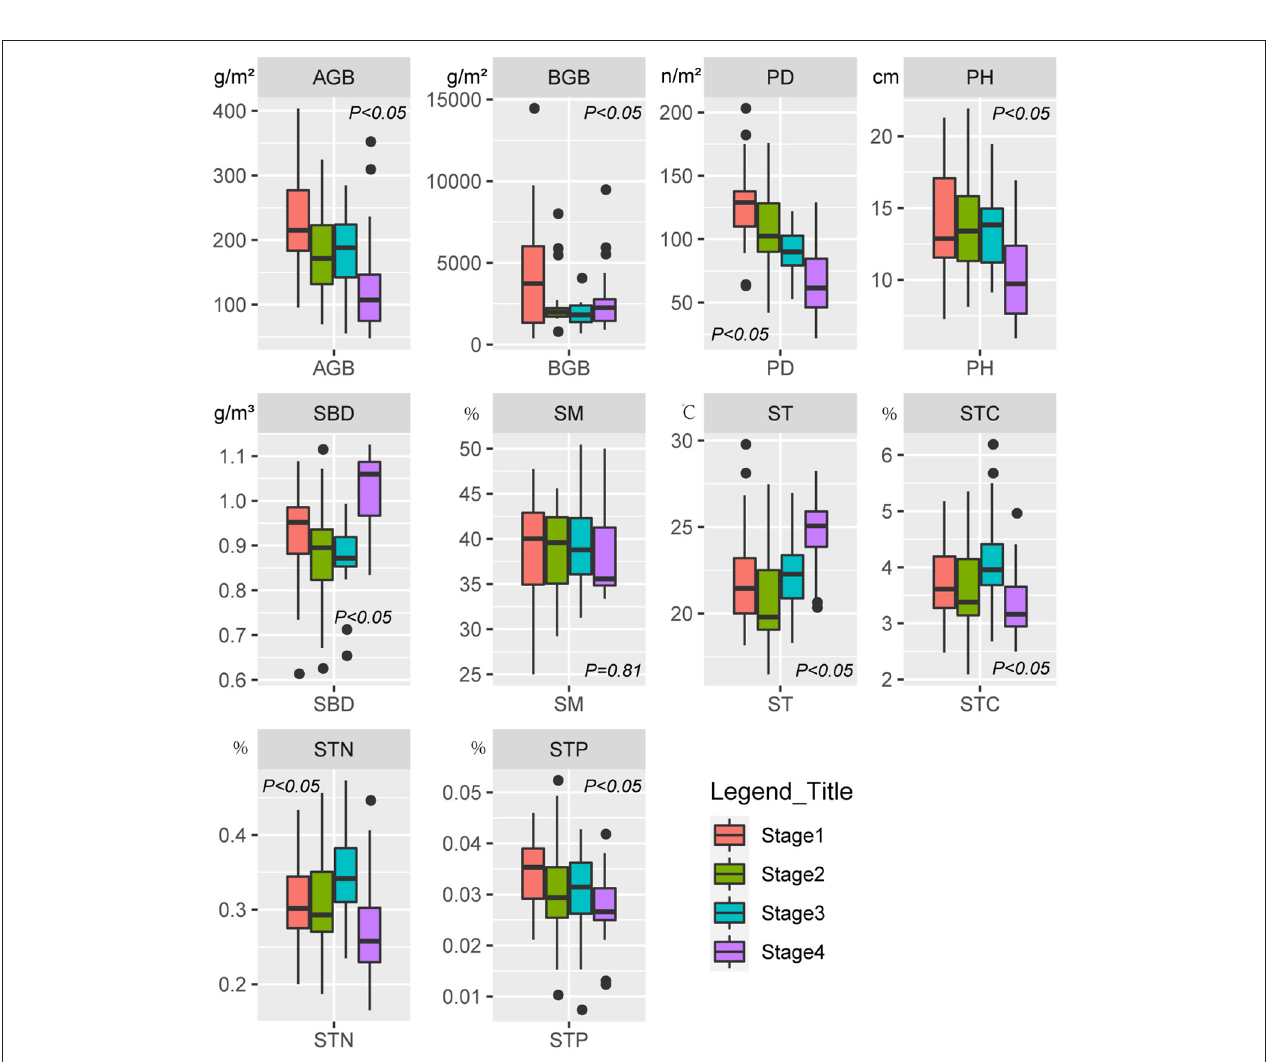
FIGURE 3 | Box plots showing changes in the aboveground biomass (AGB), belowground biomass (BGB), plant density (PD), plant height (PH), soil bulk density (SBD), soil moisture (SM), soil temperature (ST), soil total carbon (STC), soil total nitrogen (STN), and soil total phosphorus (STP) in different successional